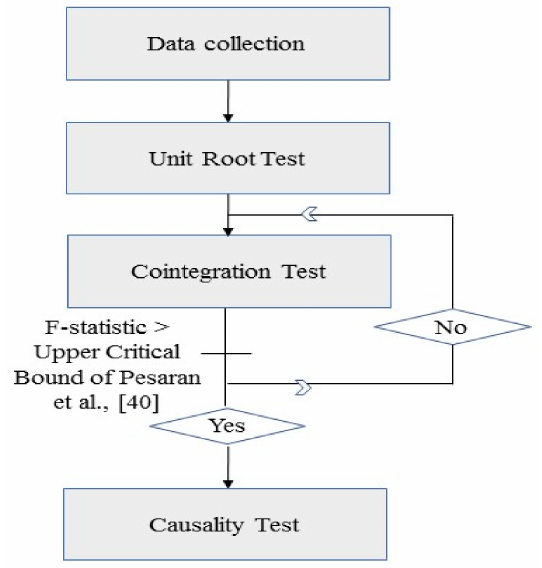
Figure 2. Steps of the